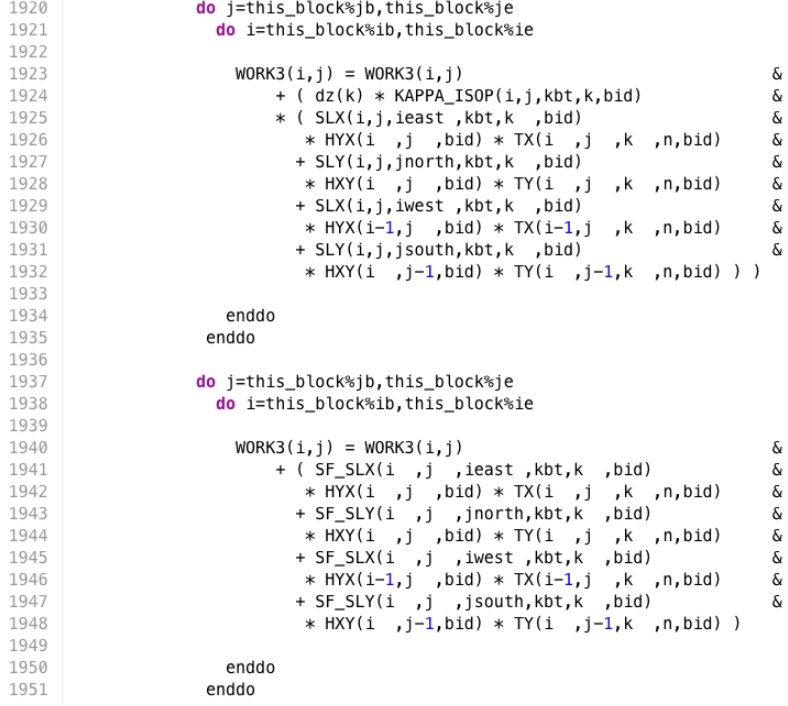
Figure 3. Part of the code lines of the compilation-sensitive code segment in the code file hmix_gm.F90 of POP2. It is found that the code from line 1923 to line 1932 can produce significantly different results when different compiling setups are